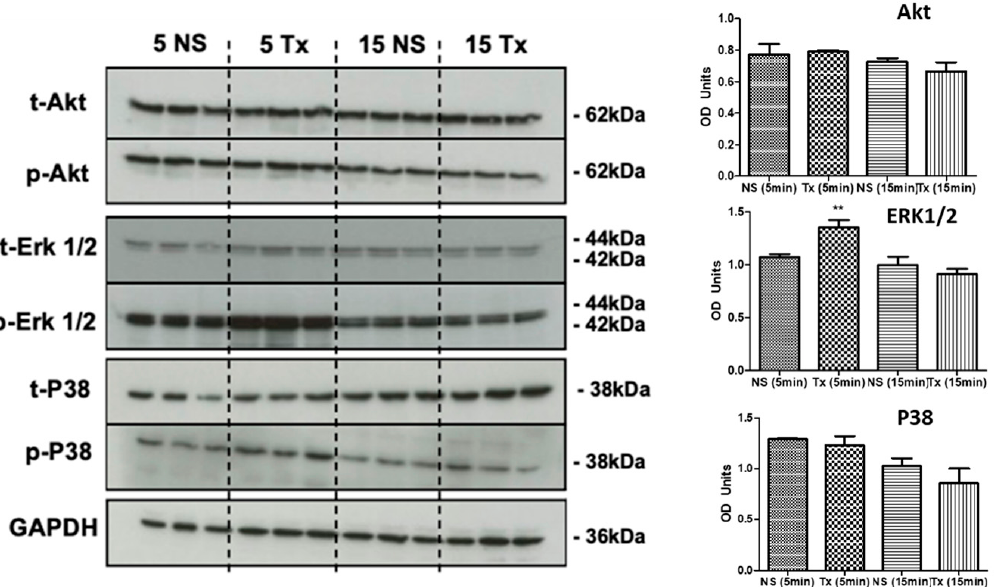
Figure 7. Western blots showing the total and phosphorylated proteins Akt, ERK 1/2, P38, and the loading control GAPDH following treatment with 100 nM of asprosin terminated at 5 and 15 min;